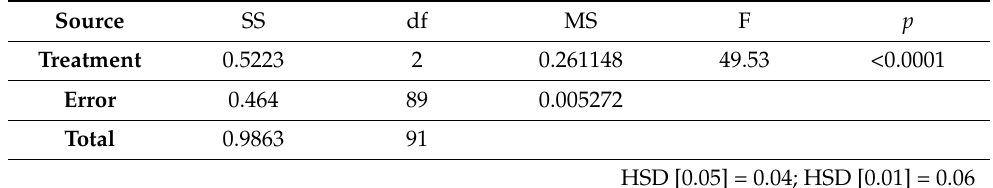
Table 6. ANOVA and Tukey Test for Accuracy .